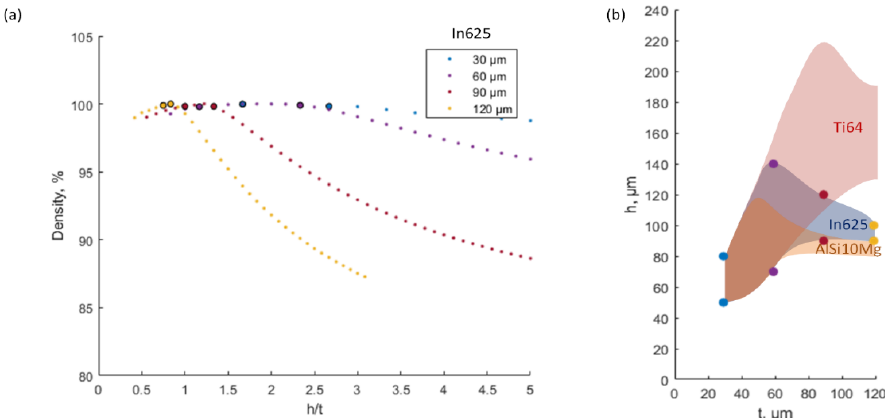
Figure 8. Hatching space/Layer thickness relations: ( a ) density as a function of the h/t ratio; ( b ) hatching space as a function of the layer thickness for maximum density ≥ 99.5% (IN625, AlSi10Mg and Ti64 powders for an EOS M280 LPBF system).